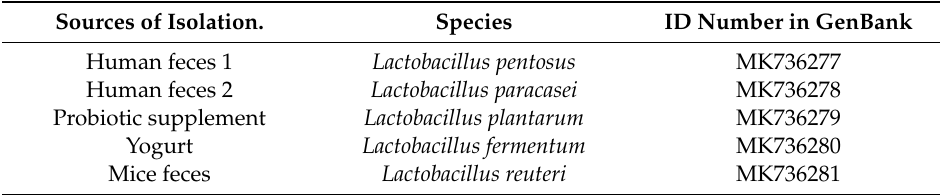
Table 1. Lactic acid bacteria (LAB) sequence analysis of 16S